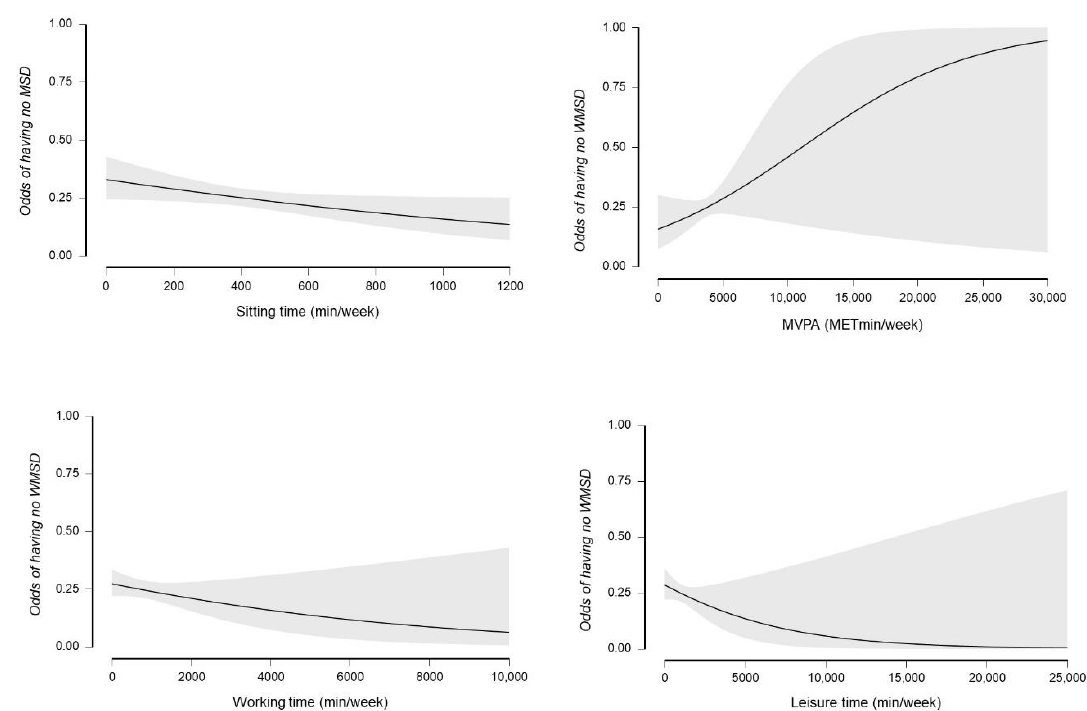
Figure 2. Association between the odds of not having WRMSDs and the physical activity variables. Except for MVPA (METmin/week), all other variables (sitting time, leisure time high intensity exercise, and working time) were inversely associated with the probability of not having WRMSDs; Abbreviation: MVPA = Moderate – vigorous physical activity.